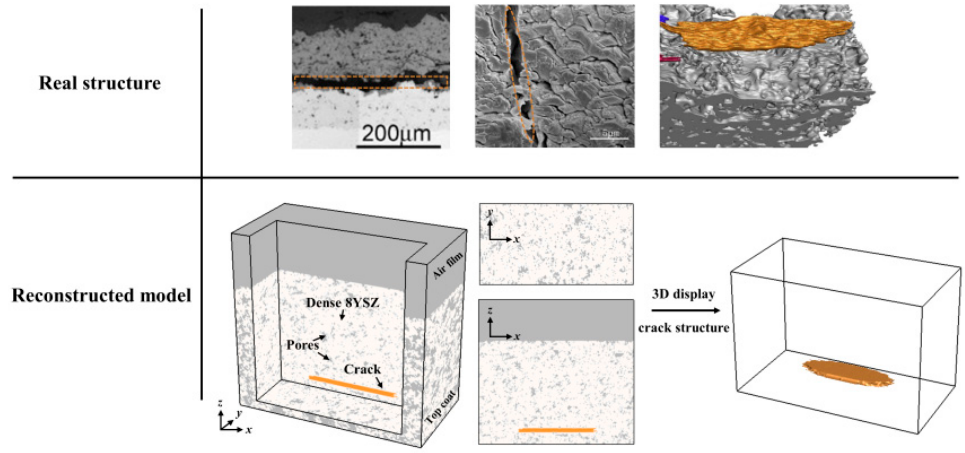
Figure A1. The reconstructed model with pores and crack generated by regulating characteristic parameters extracted from the real structures.